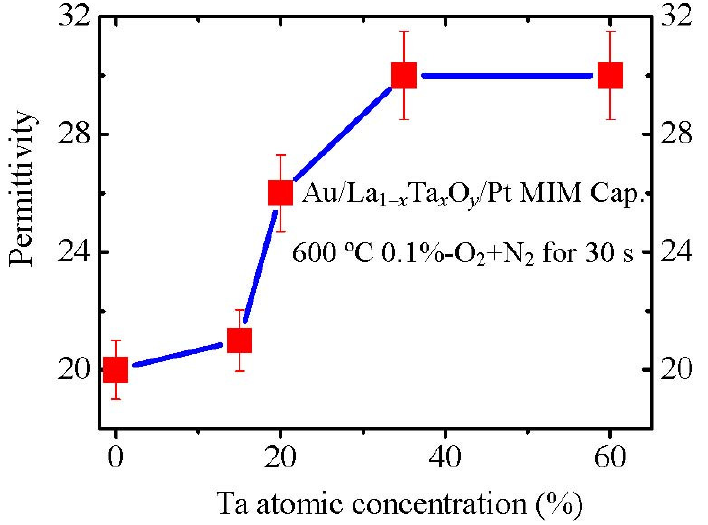
Ta O films with Ta x y 1− x